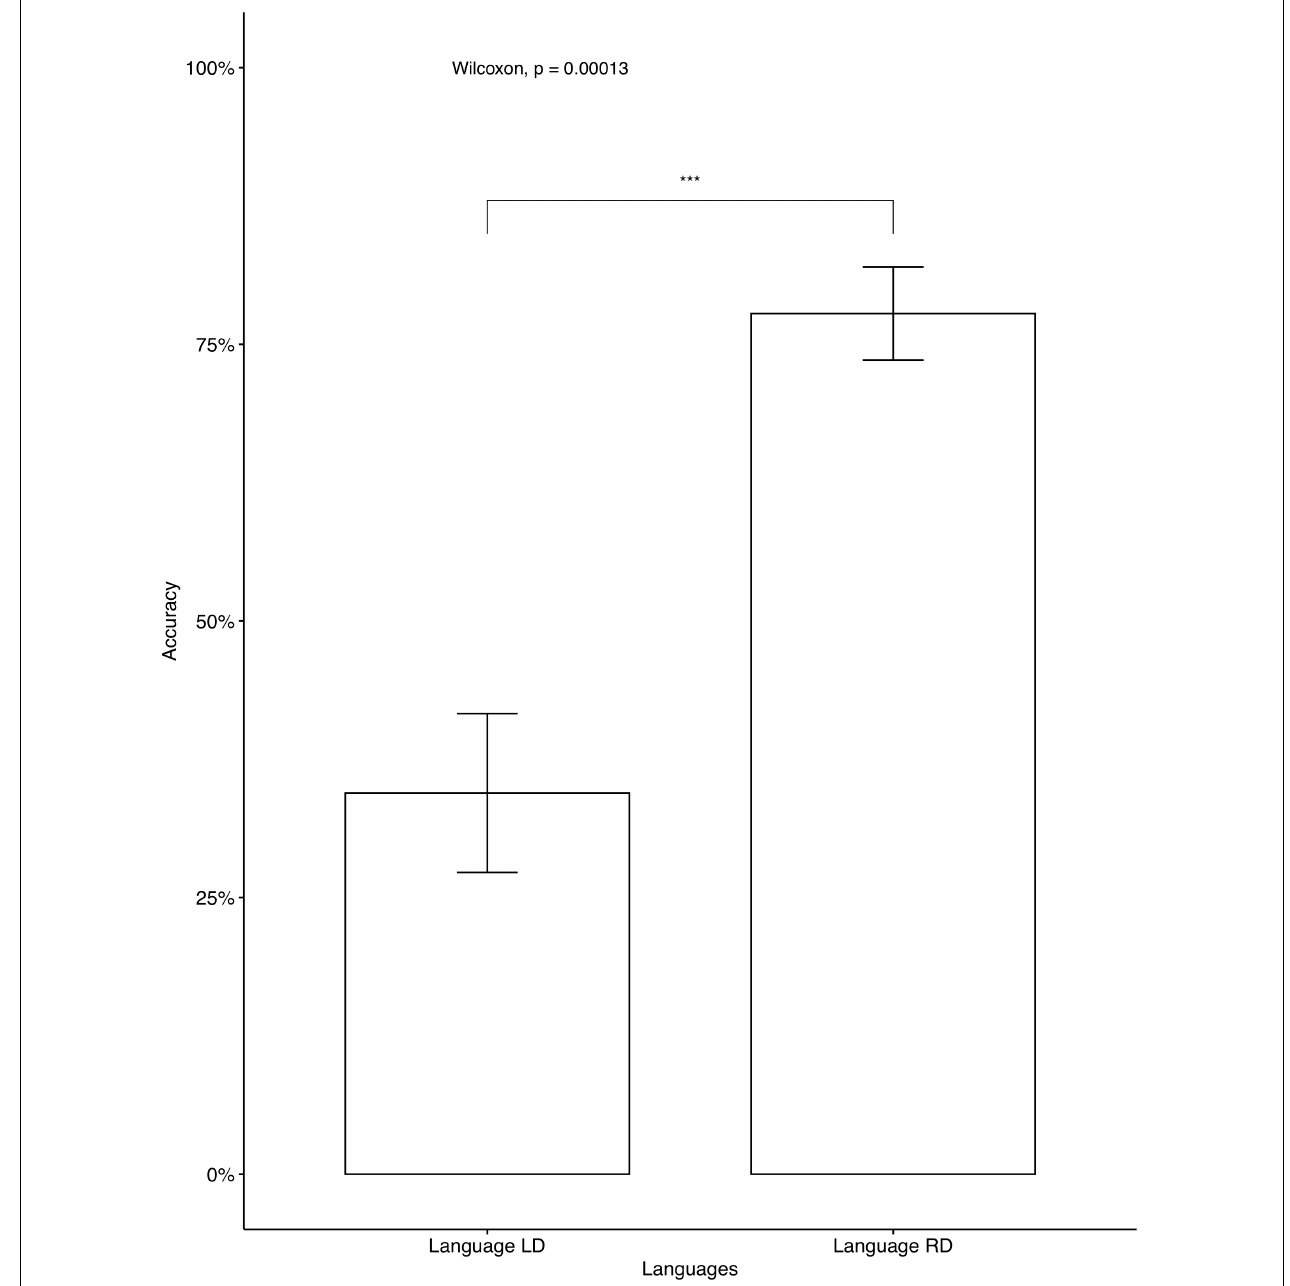
FIGURE 6 | Accuracy on critical unseen items: Cantonese native speakers. The 95% confidence interval is specified for each bar. ***indicates significant mean difference, p < 0.001.